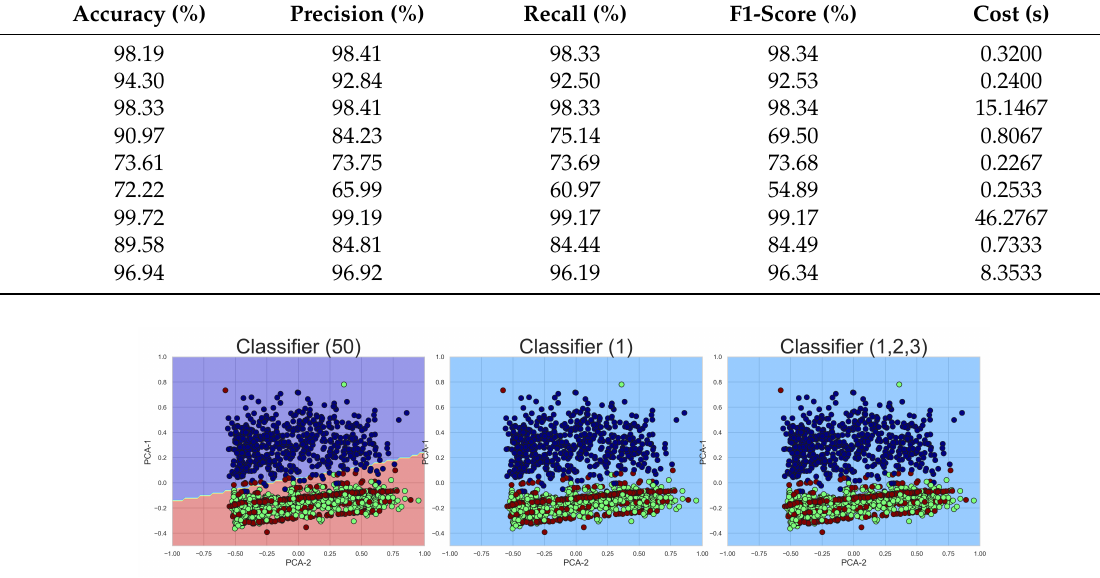
Figure 20. Fault Visualization plot aided with PCA for a dissipation factor dataset.